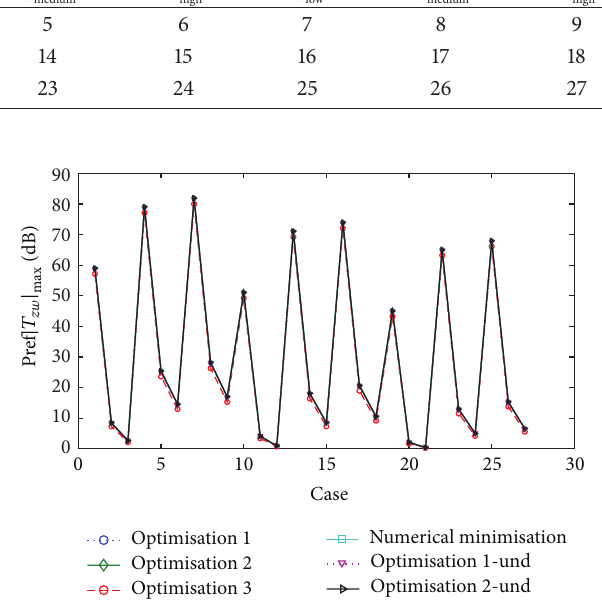
Figure 14: Perf |𝑇 𝑧𝑤 | max for all the methods considered and for all the cases listed in Table 5.